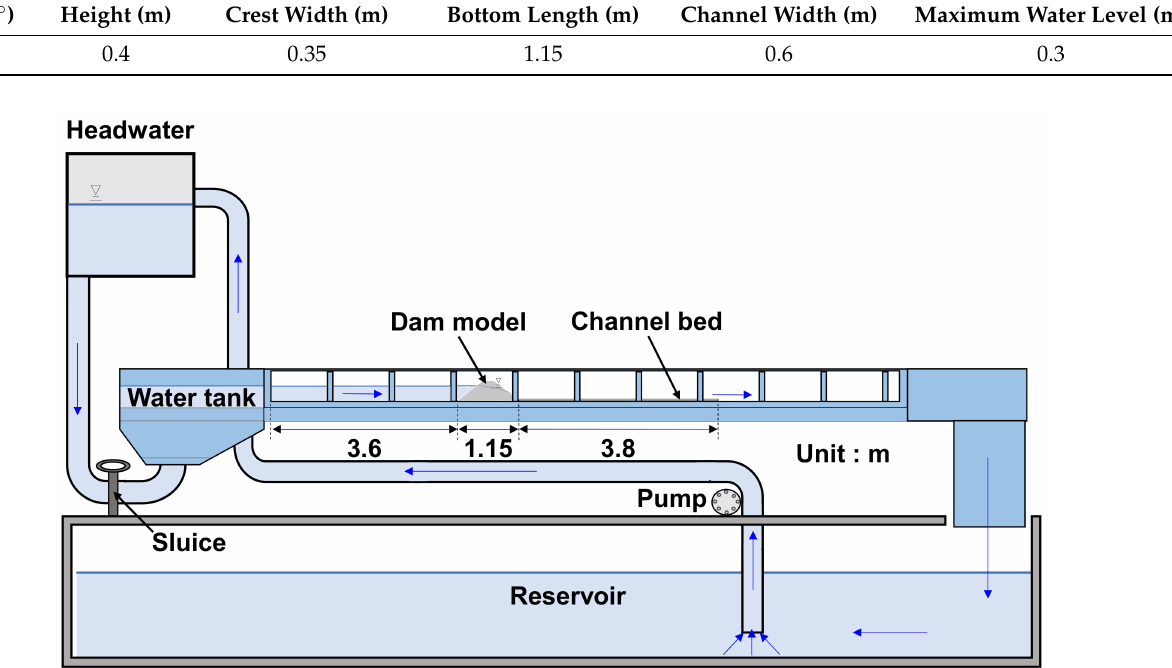
Figure 1. Layout of the test flume and the dam model.